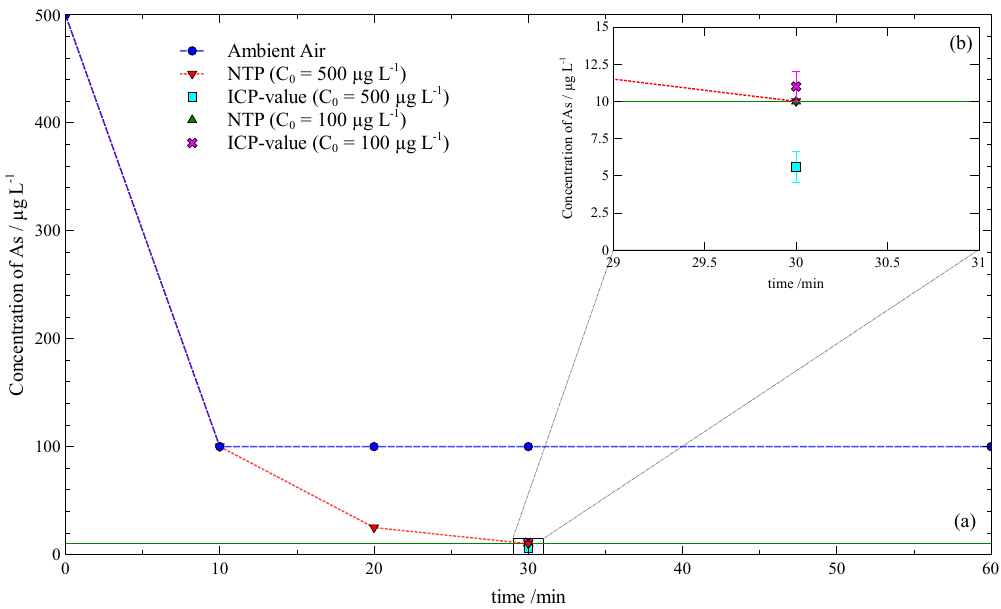
Figure 3. Concentration of remaining As(III) as a function of time and treatment method ( a ). The inset ( b ) is a magnification of the region of interest (i.e., As concentration around 10µgL − 1 ). The values obtained with the test strips are in close proximity to the more accurate ICP-MS measurements. The green line shows the WHO limit of 10µgL − 1